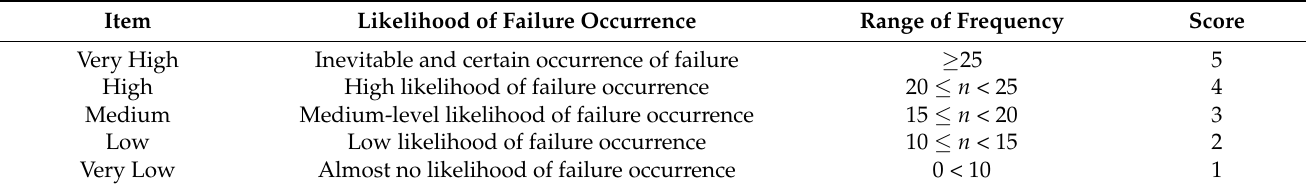
Table 1. Occurrence criteria.